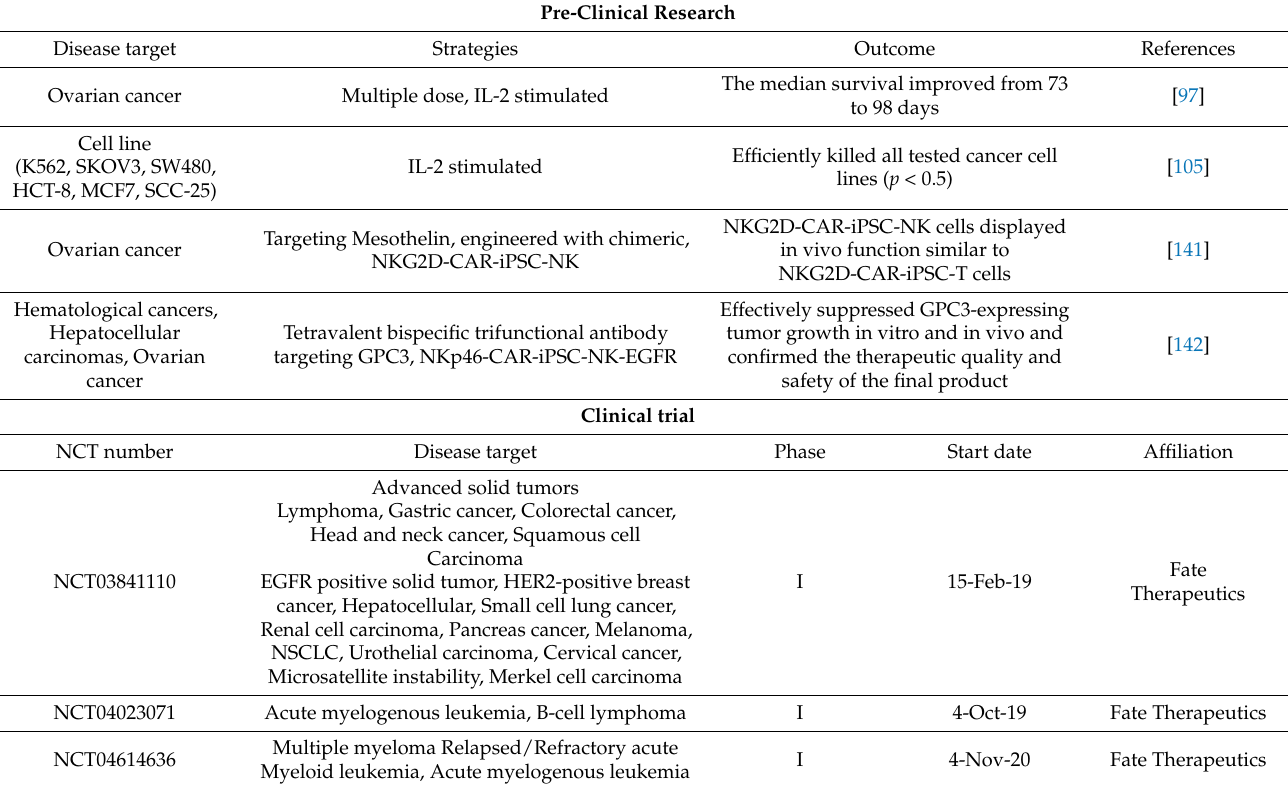
Table 2. iPSC-NK cell therapy for